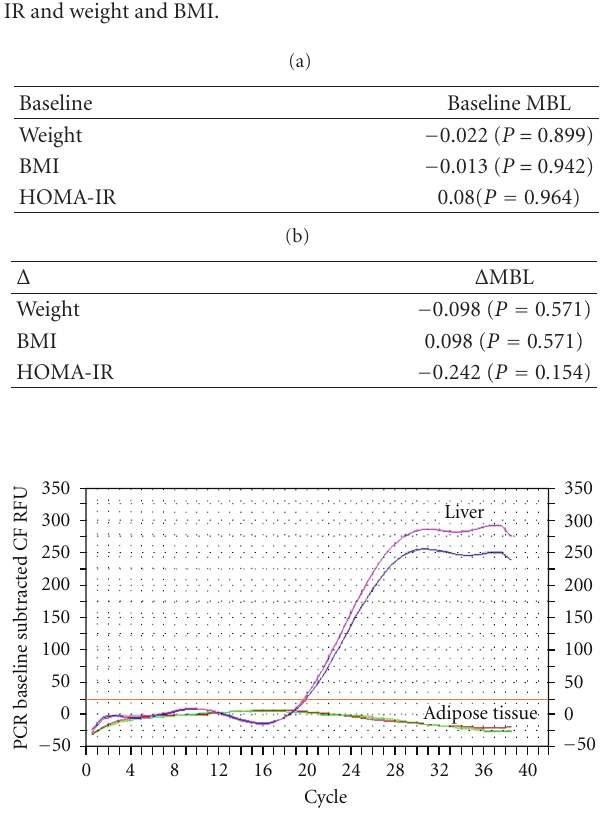
Figure 2: PCR of MBL in human liver and adipose